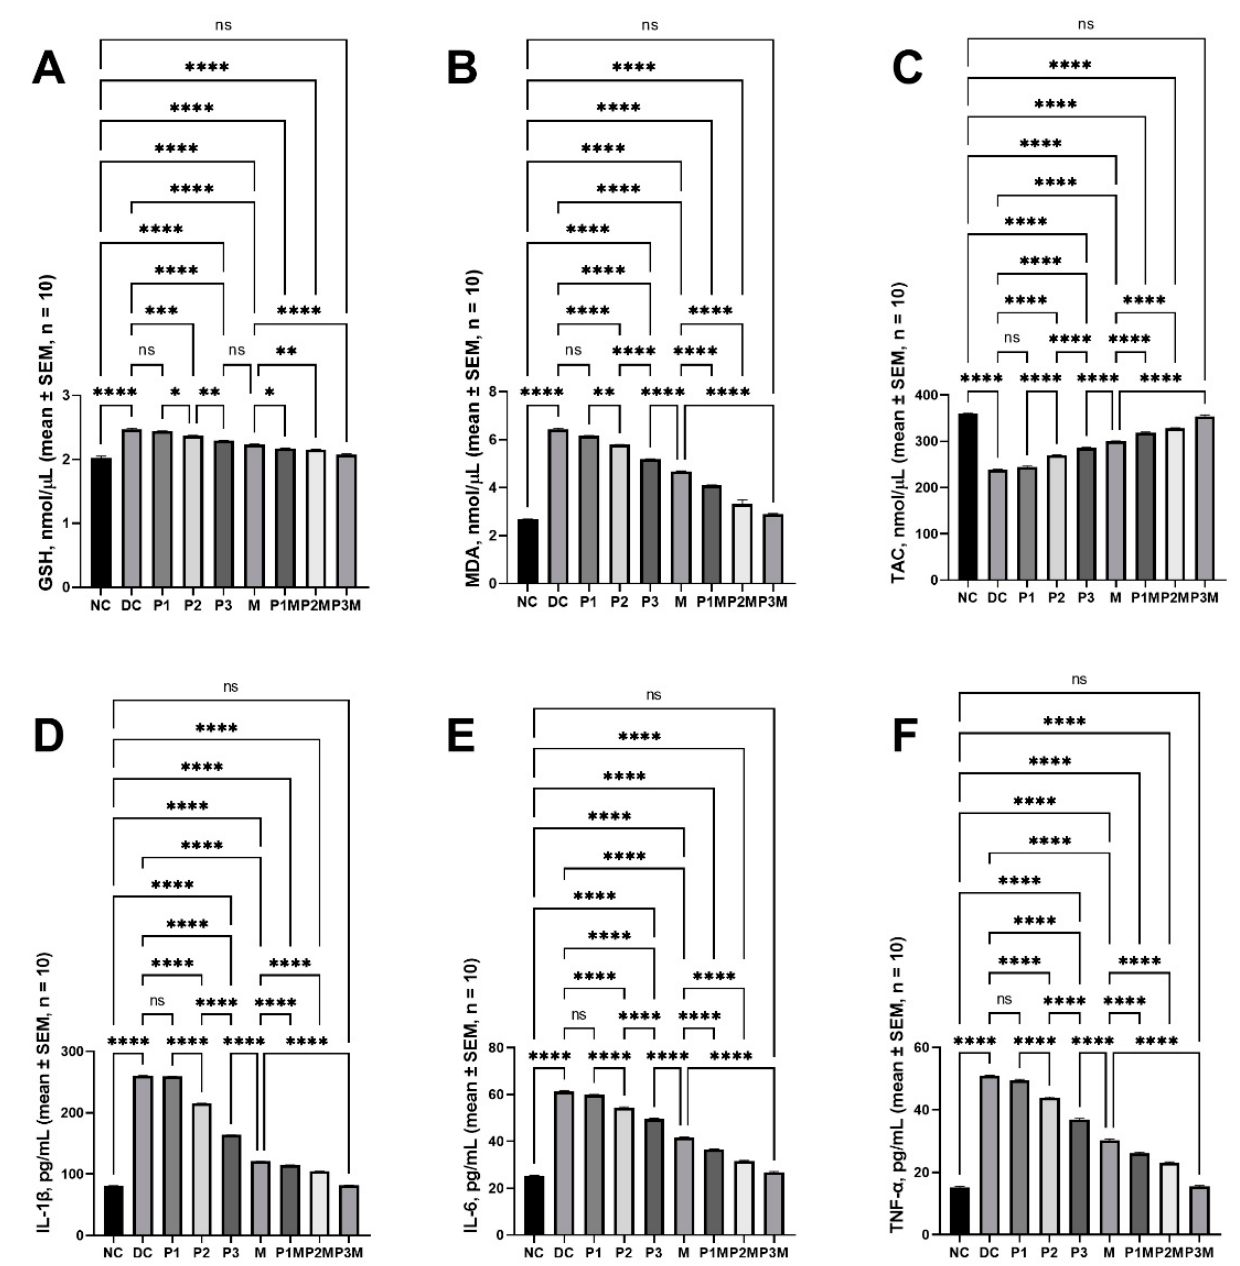
Figure 2. The pharmacodynamic activity of puerarin and metformin and the effects of the pharma- codynamic interaction between puerarin and metformin on the oxidative stress and inflammation.